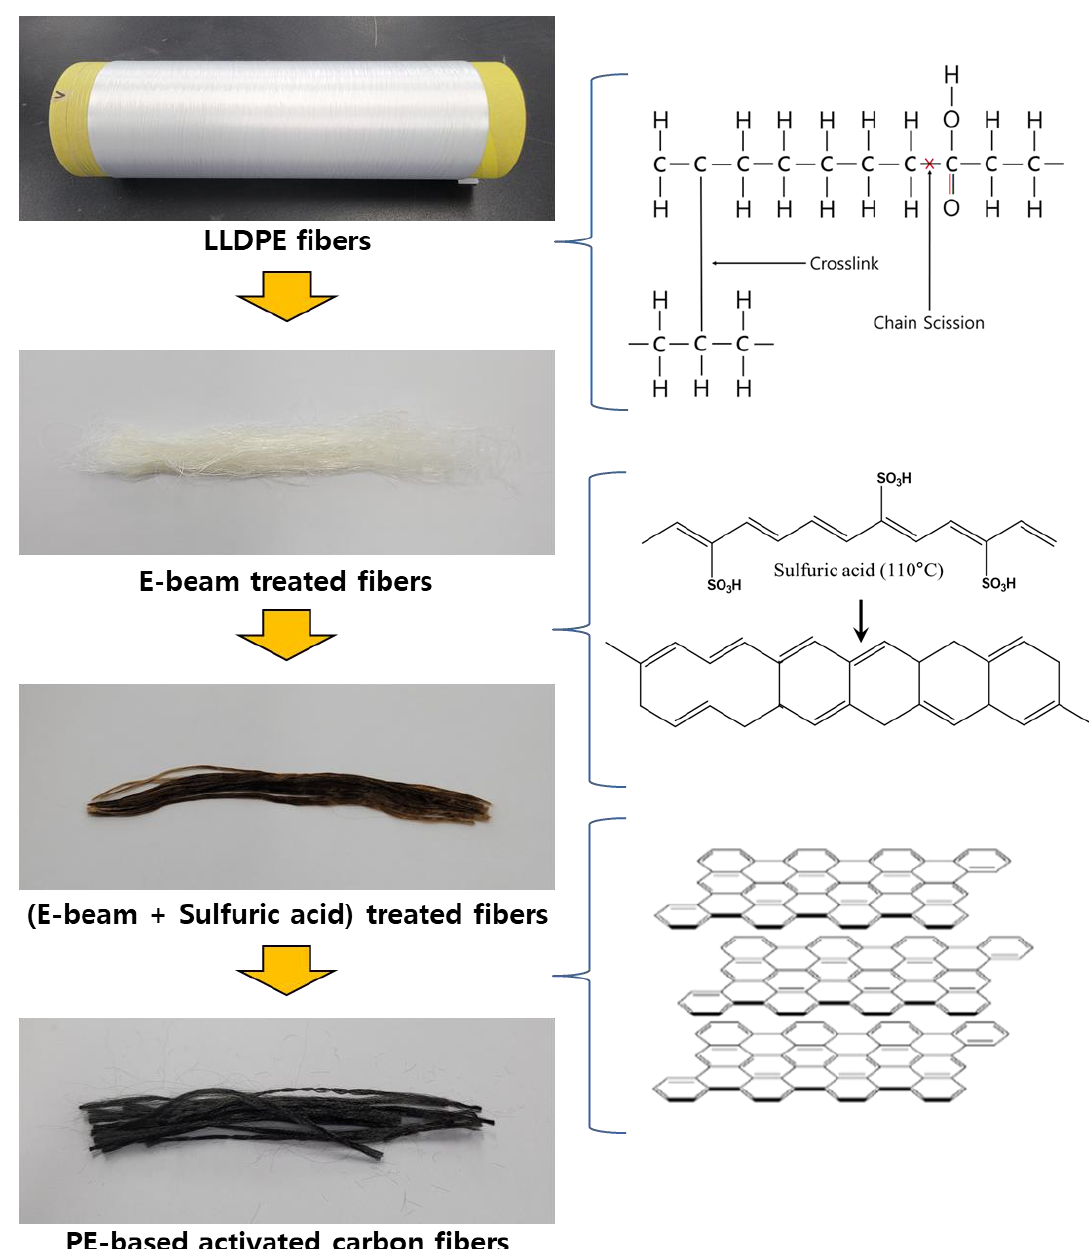
Figure 1. Manufacturing process of linear low-density polyethylene (LLDPE) based activated carbon Table 1. Sample names according to crosslinking and activation conditions.